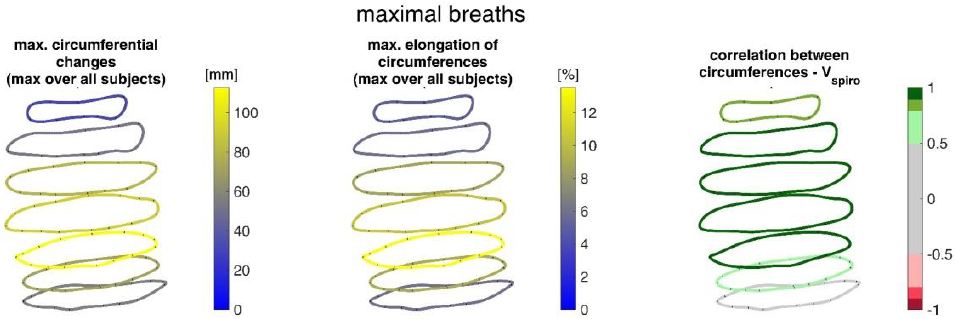
Figure 16. Illustration of the circumferences at seven different heights on the upper body determined via closed spline curves by the MoCap markers. The largest circumference changes amongst all subjects during maximal breaths (left), the maximal corresponding circumference elongation (center), and the mean corresponding correlation of circumferences with spirometer volume V spiro of all subjects during maximal breaths are shown (right).